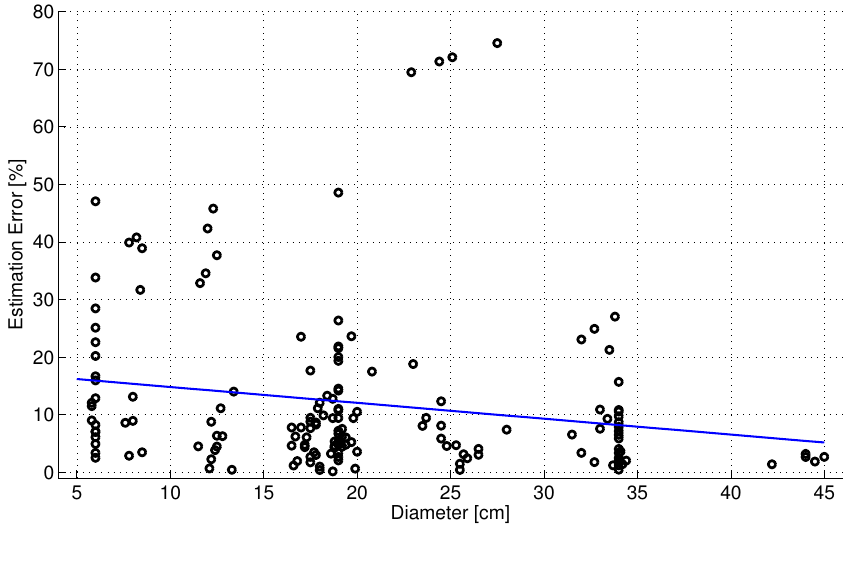
Figure 7. The estimation error decreases with increasing diameter (n = 170).